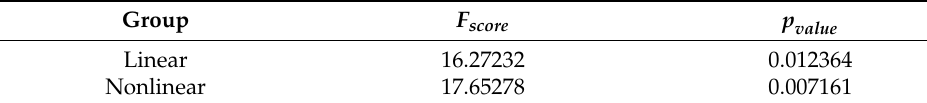
Table 14. Values obtained with the Kruskal–Wallis test.